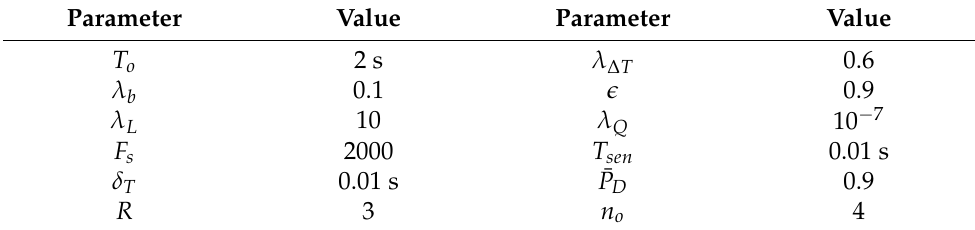
Table 3. PU traffic parameters and other parameters configurations.